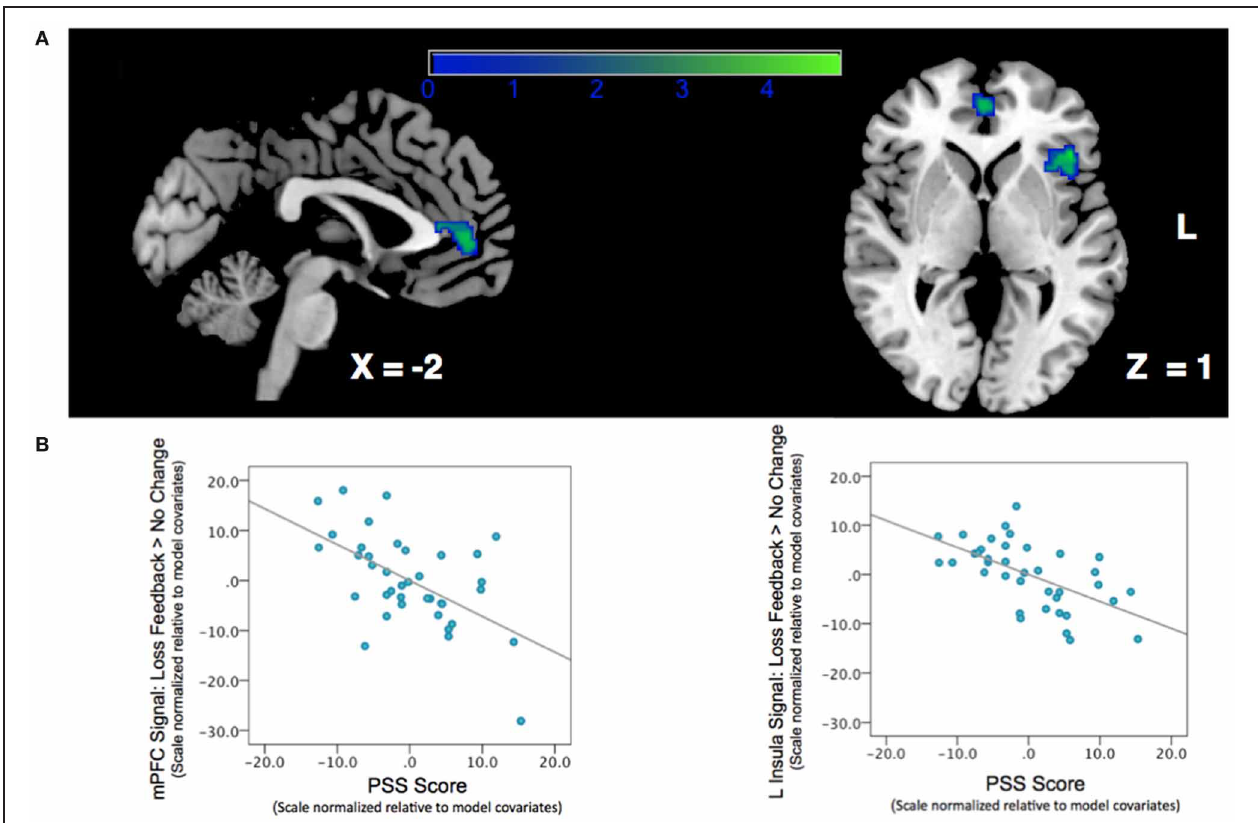
FIGURE 3 | Association between Perceived Stress and mPFC BOLD signal during a contrast of Loss Feedback > No Change Feedback. (A) SPM depicting mPFC and insula clusters. Clusters are significant after correcting for multiple-comparisons using a cluster-extent correction procedure p cluster < 0 . 05. Color-bar indicates